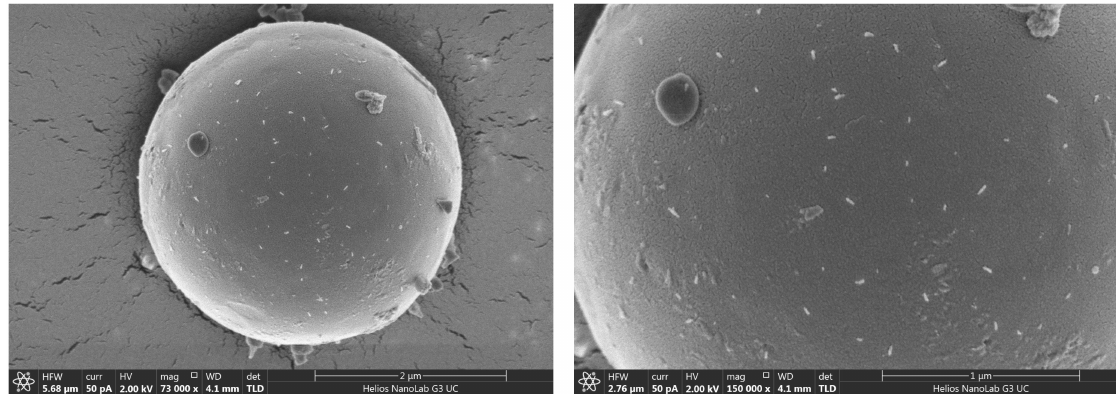
Figure 14. SEM images of aluminum